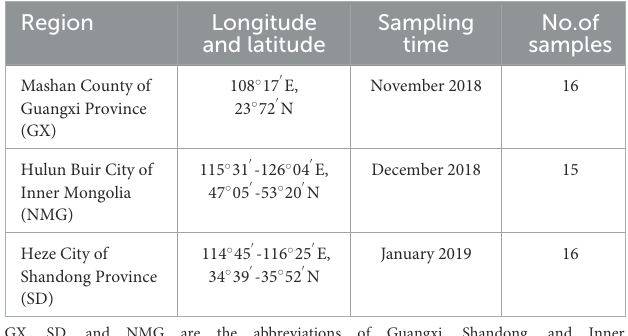
TABLE 1 Region-wise information of bovine stick bone samples.